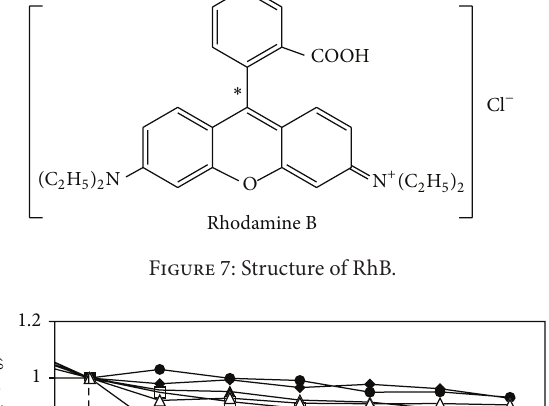
Figure 7: Structure of RhB.